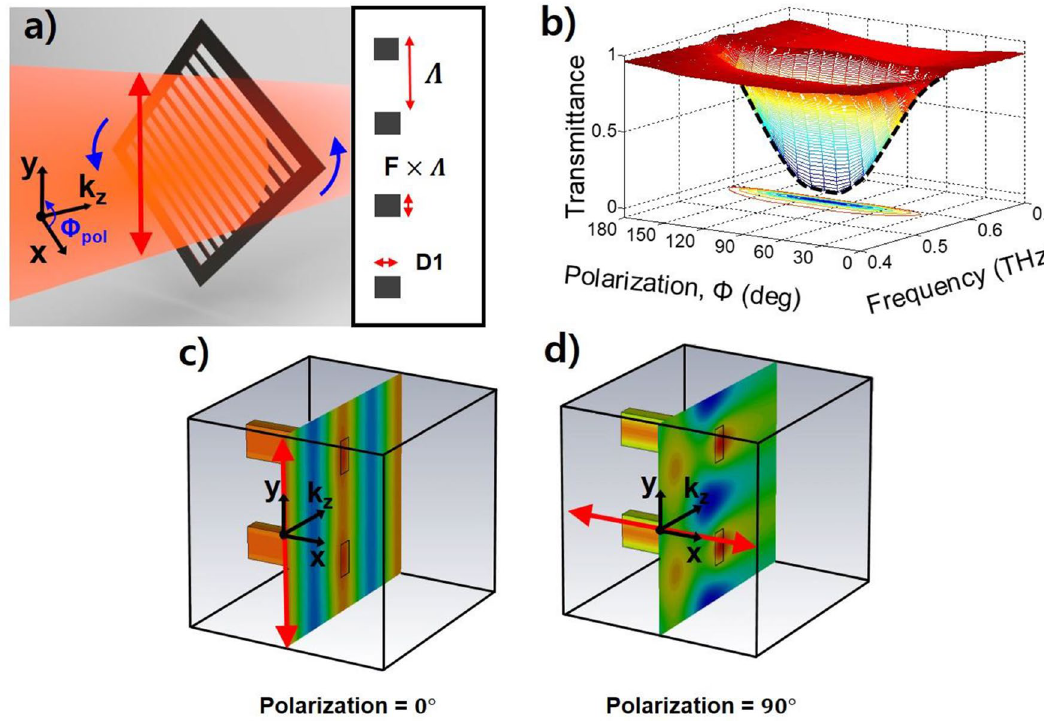
Figure 1. Transmittance properties of a single monolayer GMR notch filter. ( a ) Schematic diagram of the monolayer GMR notch filter at a 45° polarization angle. We set the angle to be 0° when the filter grating and wave polarization are orthogonal. The linearly polarized (y-direction) THz wave enters the monolayer GMR notch filter with a diameter of 25 mm. Instead of turning the polarization of the incident THz wave, the filter rotates counterclockwise. The inset figure shows the cross section of the filter. Each grating pattern consists of a height (D1) of 75 µm, period (Λ) of 510 µm, and filling factor (F) of 32%. ( b ) Measured transmittance according to the polarization angle from 0° to 180° and the wave frequency from 0.4 to 0.7 THz. The dashed black line indicates the numerically calculated transmittance. ( c ) Calculated field distribution of the TM mode when the polarization angle is 0°. The two square-shaped lines in the electric field distribution surface are the outlines of the grating structure. The red arrow indicates the polarization of the incident THz wave. ( d ) Calculated field distribution of the TE mode when the polarization angle is